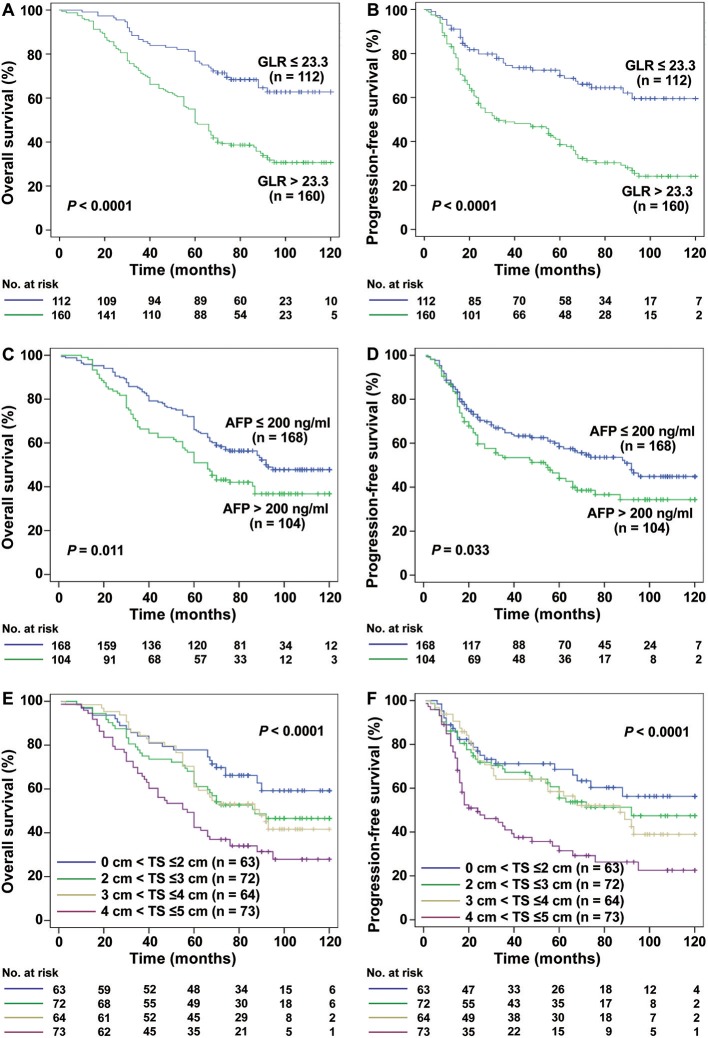
Kaplan-Meier estimated survival curves of HCC (TS ≤ 5 cm) patients after radical resection. (A,B) Kaplan-Meier analysis showed that the GLR ≤ 23.3 group (n = 112) had a higher rate of OS and PFS than those with GLR > 23.3 (n = 160) (both P < 0.0001). (C,D) The OS and PFS rate of AFP ≤ 200 ng/ml group (n = 168) were also higher than AFP > 200 ng/ml group (n = 104) (both P < 0.05). (E,F) In the different tumor size groups, the smaller the tumor size is, the higher the rate of OS and PFS in HCC ( ≤ 5 cm) patients (P < 0.0001).